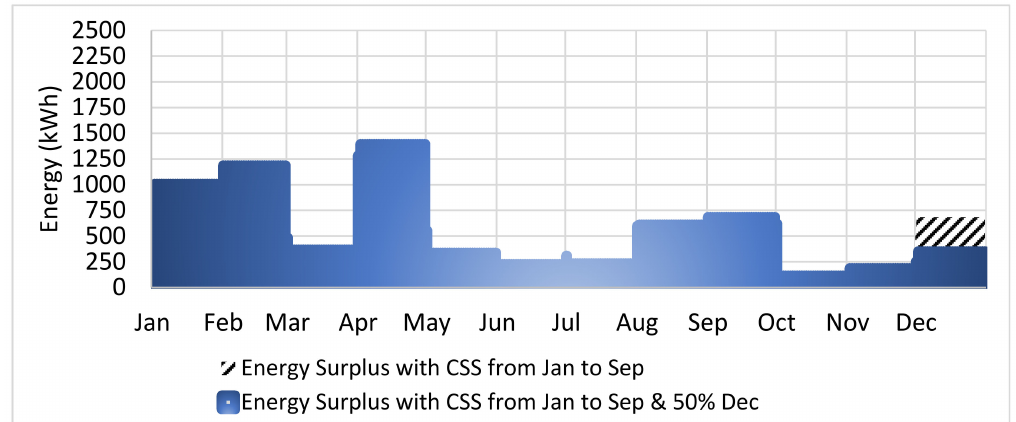
Figure 19. Monthly surplus energy from RES with BSS and optimized operation of